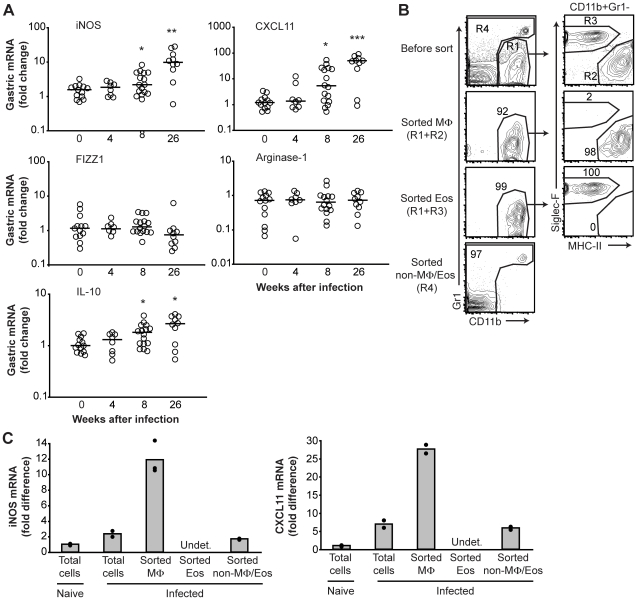
M1 polarization of gastric macrophages after H. pylori infection.(A) Expression of genes associated with macrophage polarization in the gastric mucosa of naïve and infected mice was determined by real-time PCR. Symbols represent individual mice, and horizontal bars indicate the medians. *, P<0.05 **, P<0.01 compared to the expression level in uninfected mice via Mann-Whitney U test. (B) Sorting of gastric lamina propria macrophages (Gate R1 and R2, CD11b+Gr1−Siglec-F−MHC-II+), eosinophils (Gate R1 and R3, CD11b+Gr1−Siglec-F+MHC-II−) and remaining cells after gating out macrophages and eosinophils (Gate R4, CD11b− and CD11b+Gr1+) from pooled (n = 3) mice infected for 26 weeks. Contour plots show expression of CD11b versus Gr1 on gated live cells, and expression of Siglec-F versus MHC-II on gated CD11b+Gr1− cells before and after sorting. The gates for sorting (R1–R4) are shown in the top contour plots. Numbers by gates depict cell frequencies. Note that in this experiment the few CD103+ DCs that fall into the macrophage gate (∼2%, see Fig. 1A) were not gated out. (C) Real-time PCR analysis of iNOS and CXCL11 mRNA expression by total gastric lamina propria cells pooled from naïve (n = 3) or infected (n = 3, 26 weeks) mice before sorting as well as expression by sorted macrophages (Gate R1 and R2, CD11b+Gr1−Siglec-F−MHC-II+, 9×105 cells), eosinophils (Gate R1 and R3, CD11b+Gr1−Siglec-F+MHC-II−, 6×105 cells) and remaining cells after gating out macrophages and eosinophils (Gate R4, CD11b− and CD11b+Gr1+, 3×106 cells) from infected mice. Bars are the mean of two to three replicates, and dots represent each replicate. Undet., undetected. MΦ, macrophages. Eos, eosinophils.